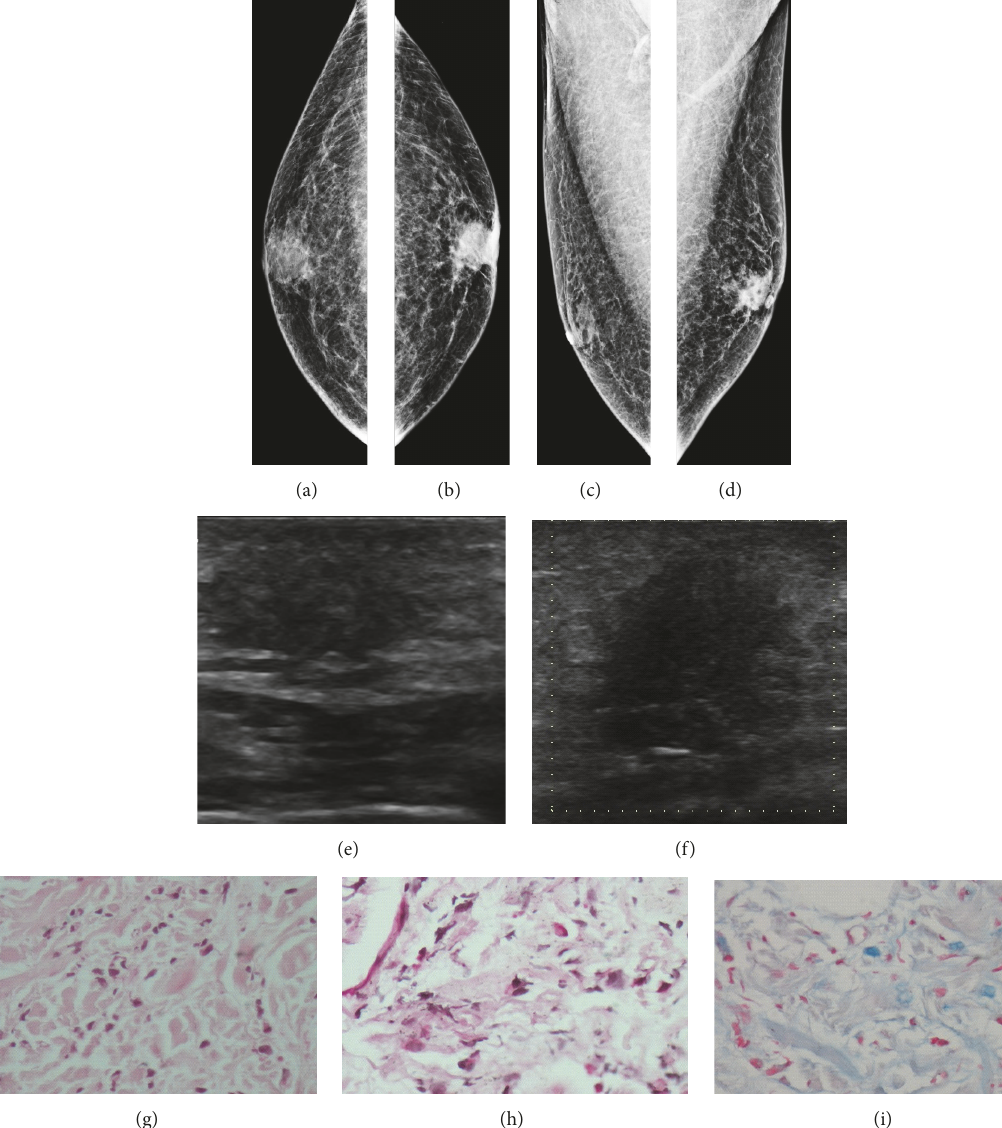
Figure10: Case10. A63-year-oldmanwithgastricsignetringcellcarcinoma.Onemonthafterdiagnosis,thepatientpresentedwithapalpable mass in the left breast ( b and d ). Mammogram showed focal asymmetry in the retroareolar region in the left breast and a high-density mass that resulted in nipple retraction ( a–d ). On ultrasound, this corresponded to a suspicious, solid heterogeneous mass with indistinct margins and posterior acoustic shadowing ( e–f ). A comparable lesion was demonstrated in the right breast. HE staining and immunohistochemistry analysis of the metastases. HE staining revealed the malignant cells in the breast tumor ( g ), and the immunohistochemistryanalysis indicated that the cells were positive for PAS ( h ) and Alcian blue ( i